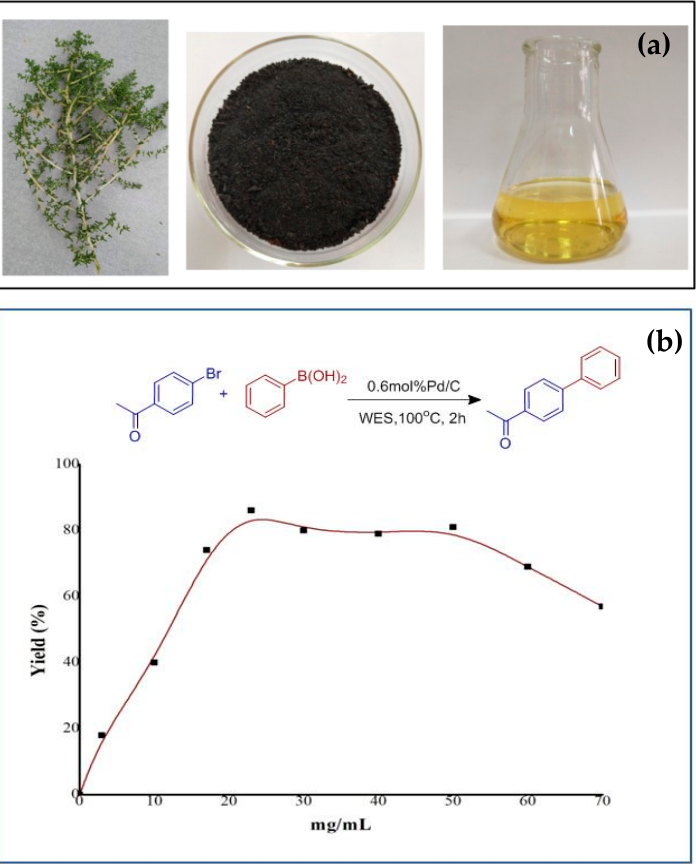
Figure 1. ( a ) Preparation of water extract of suaeda salsa (WES); ( b ) Optimization of WES concentra- tion for the S–M reaction.